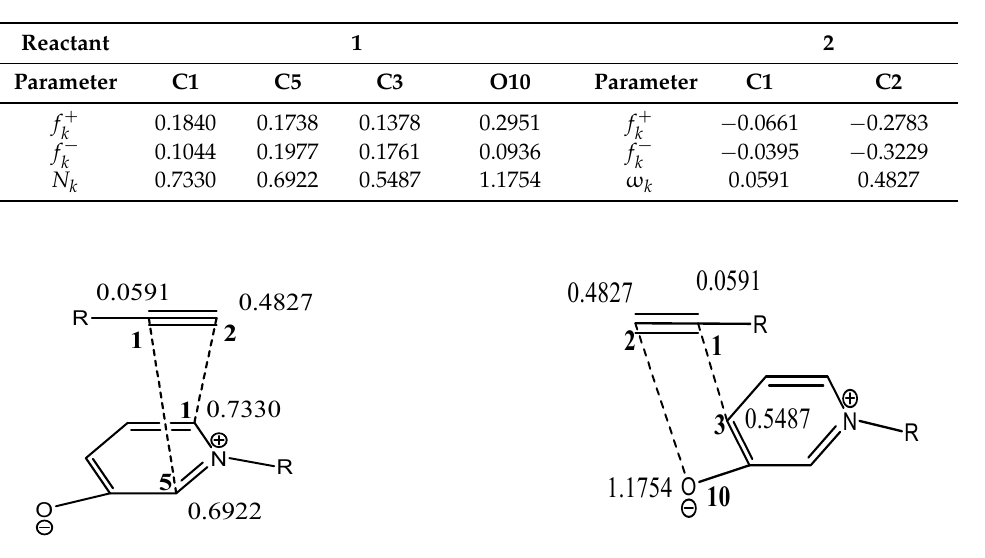
Table 3. Energies and relative energies ( ∆ E) of the reactants, transition states, and products.